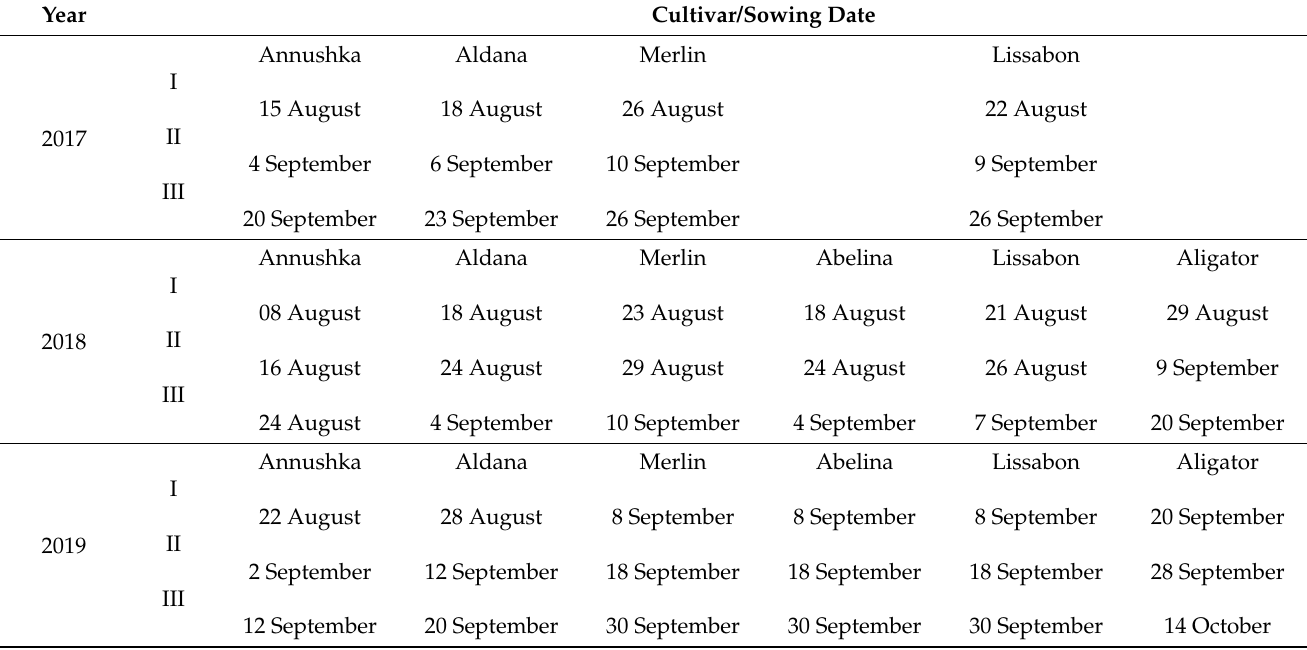
Table 2. The technical maturity of soybean cultivars depending on the sowing